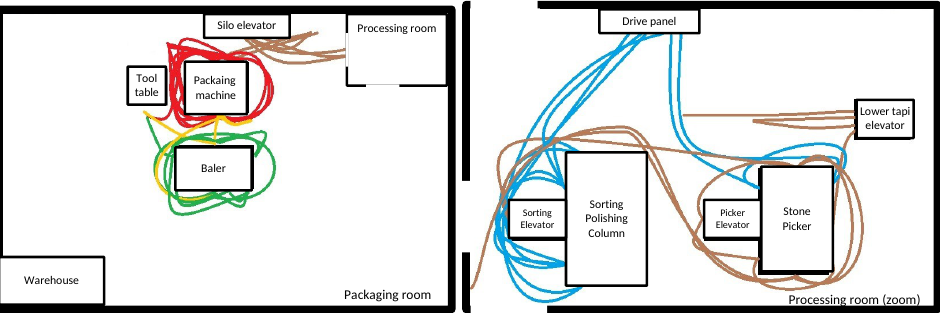
Figure 6. Spaghetti diagram of setup after cycle 2. Each color represents a different operator. At the end of the second cycle of the action research, the processing operator, repre- sented in blue, started to walk approximately 60 m, while the new repairperson, represented in brown, covered approximately 102 m. As for the new operator of the packaging oper- ation, represented in red, and the operator of the baling operation, represented in green, they moved approximately 63 and 172 m, respectively. Finally, the repairperson for the packaging and baling operations, represented in yellow, started to travel approximately 35